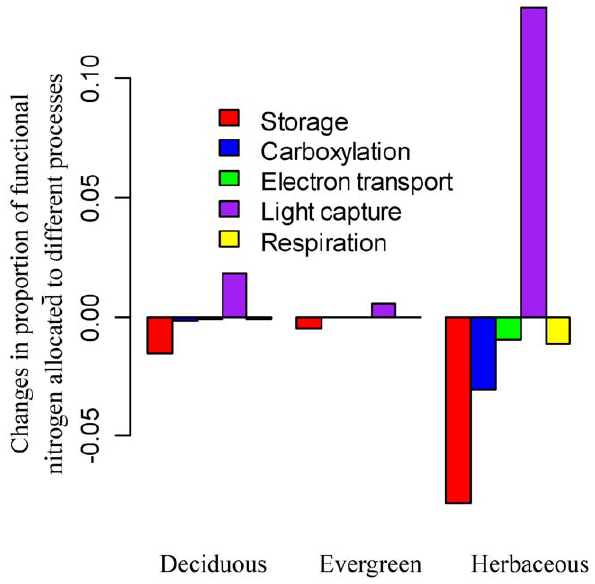
Figure 7. Radiation effects on nitrogen allocation coefficients for deciduous trees, evergreen trees, and herbaceous plants. We explore the reduced radiation from 800 to 400 m mol photon/ m 2 / s on the proportions of nitrogen allocated to storage, carboxylation, electron transport, light capture and respiration for a leaf layer with prescribed functional nitrogen availability. Positive values indicate increase in nitrogen allocation while negative values indicate decrease in nitrogen